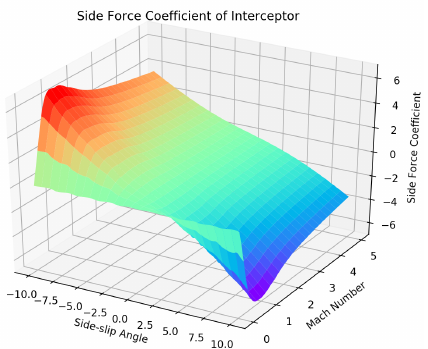
Figure 4. Side force